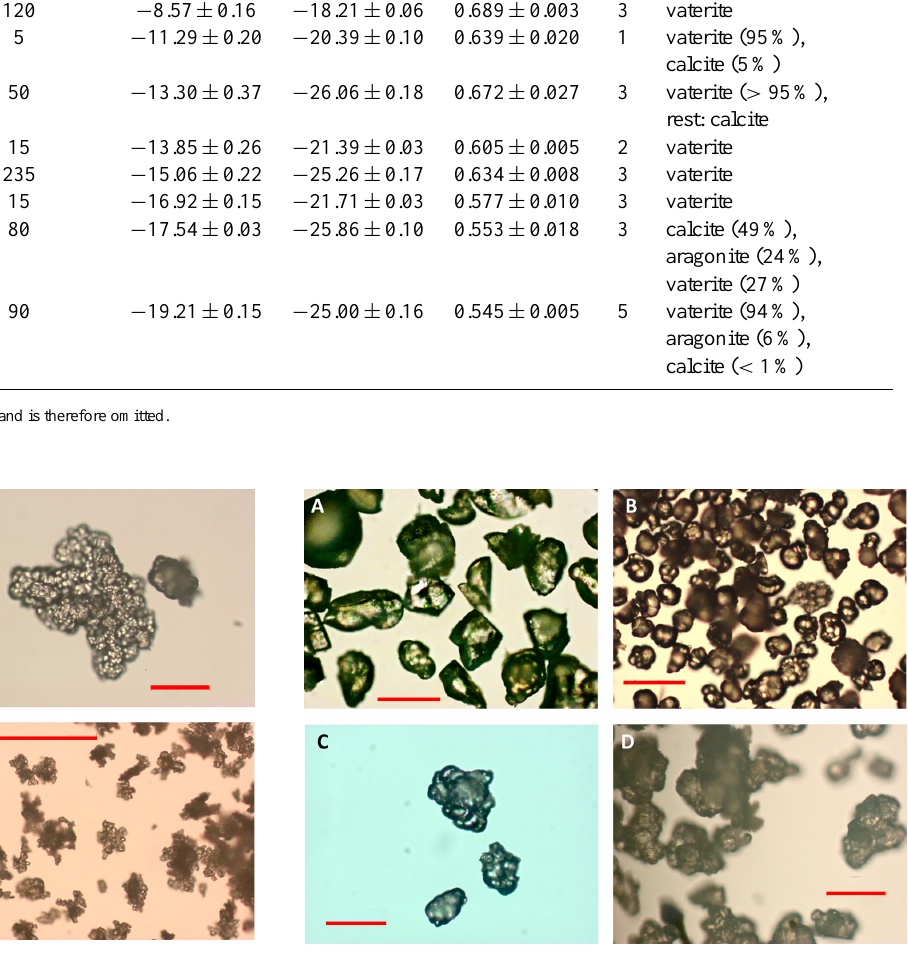
Figure 2. Photomicrographs of CaCO 3 minerals precipitated in the laboratory experiment. Scale bar is 100µm in (a) - (c) and 200µm in (d) . Vaterite crystals formed at 50 ◦ C in experiment NA-6 (a) , at 70 ◦ C (b) and at 91 ◦ C (d) . At 80 ◦ C a mixture of aragonite, calcite and vaterite was precipitated (c) .